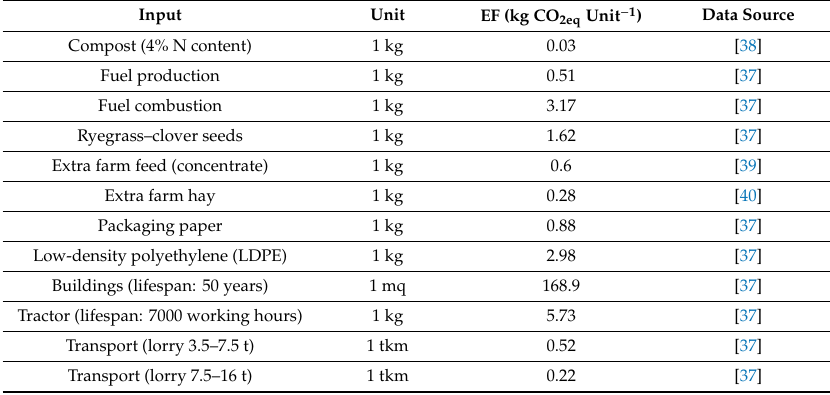
Table 2. Emissions factors (EFs)